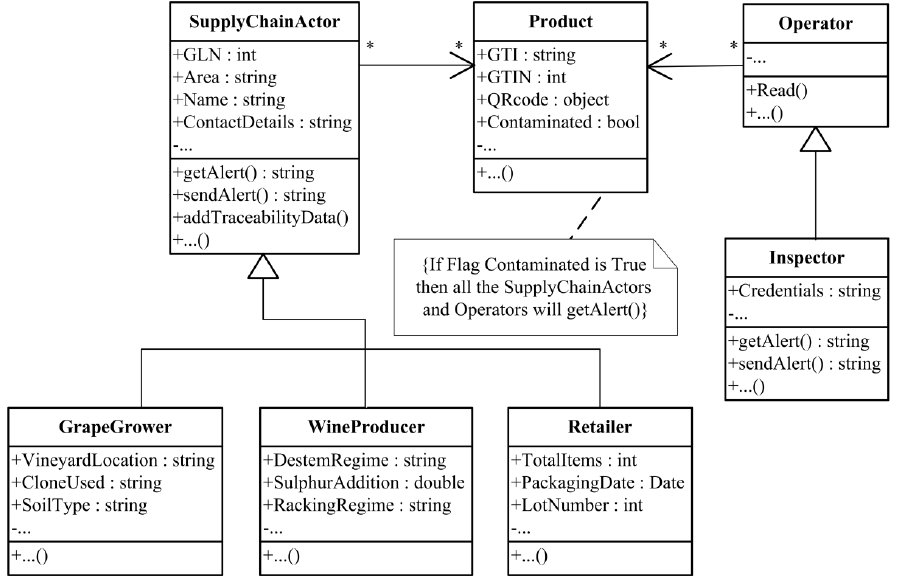
Figure 2 . UML class diagram. The figure shows the wine traceability data model. Figure 2. UML class diagram. The figure shows the wine traceability data